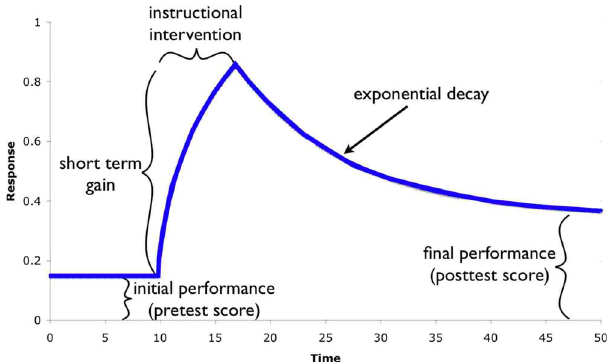
FIG. 1. (cid:1) Color online (cid:2) A simulated response to teaching. The curve has four labeled parameters: initial height, short term gain during an instructional intervention, exponential decay constant, and